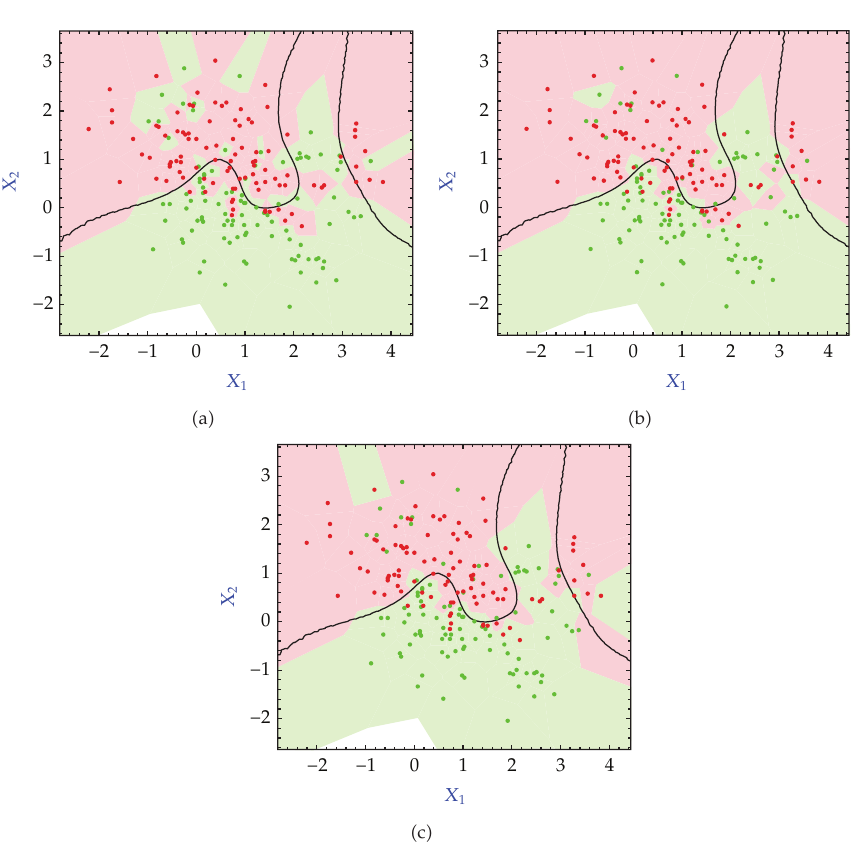
Figure 2: K -fuzzy nearest neighbor (cid:2) Keller et al, 1985 (cid:3) and stimuli (cid:2) by Ian McLeod (cid:3) . K -fuzzy nearest neighbor under K (cid:4) 3 , 7 ,